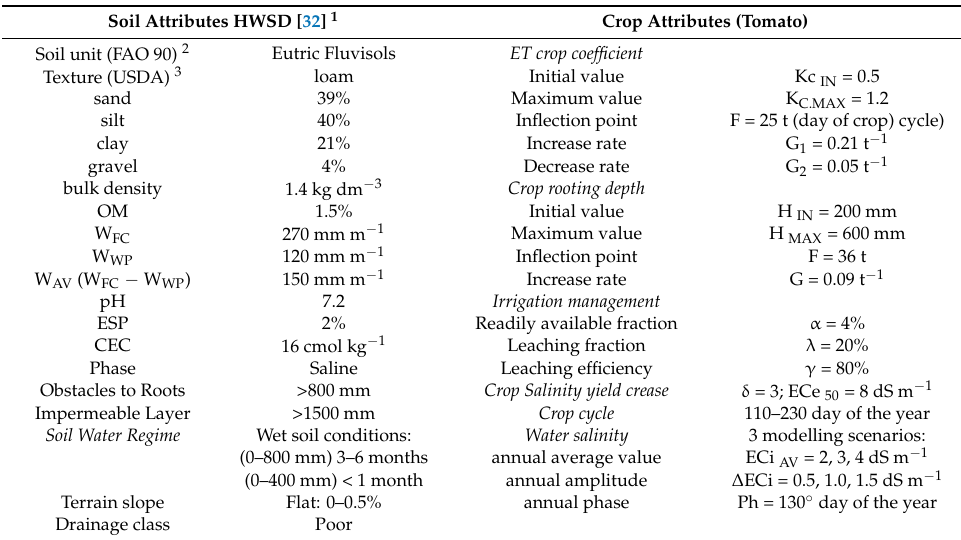
Figure 3. Climatic characterization of the reference area. Monthly averages of long-term climatic data (1975–2017) are reported. ( a ) Reference evapotranspiration (ET 0 ) and precipitation (P); ( b ) De Martonne aridity index (AI). Table 1. Soil, water, and crop attributes utilized in the